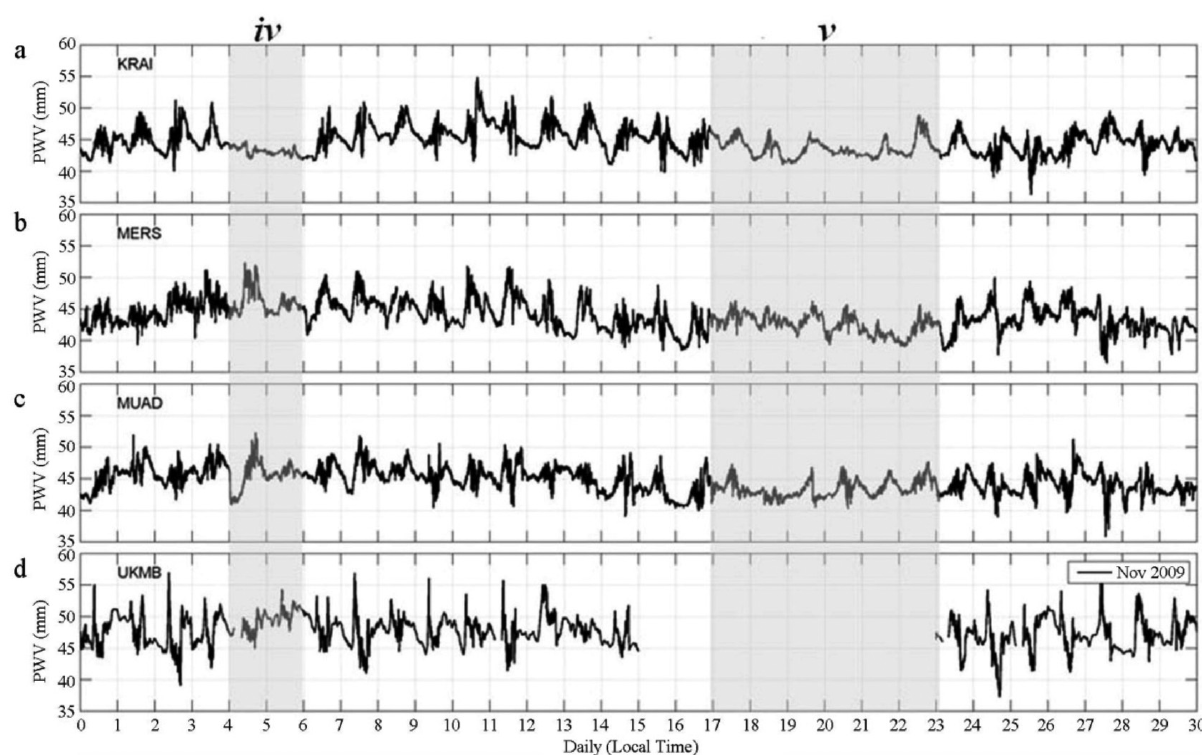
Figure 8. GPS PWV variation during the second inter-monsoon at four selected stations.